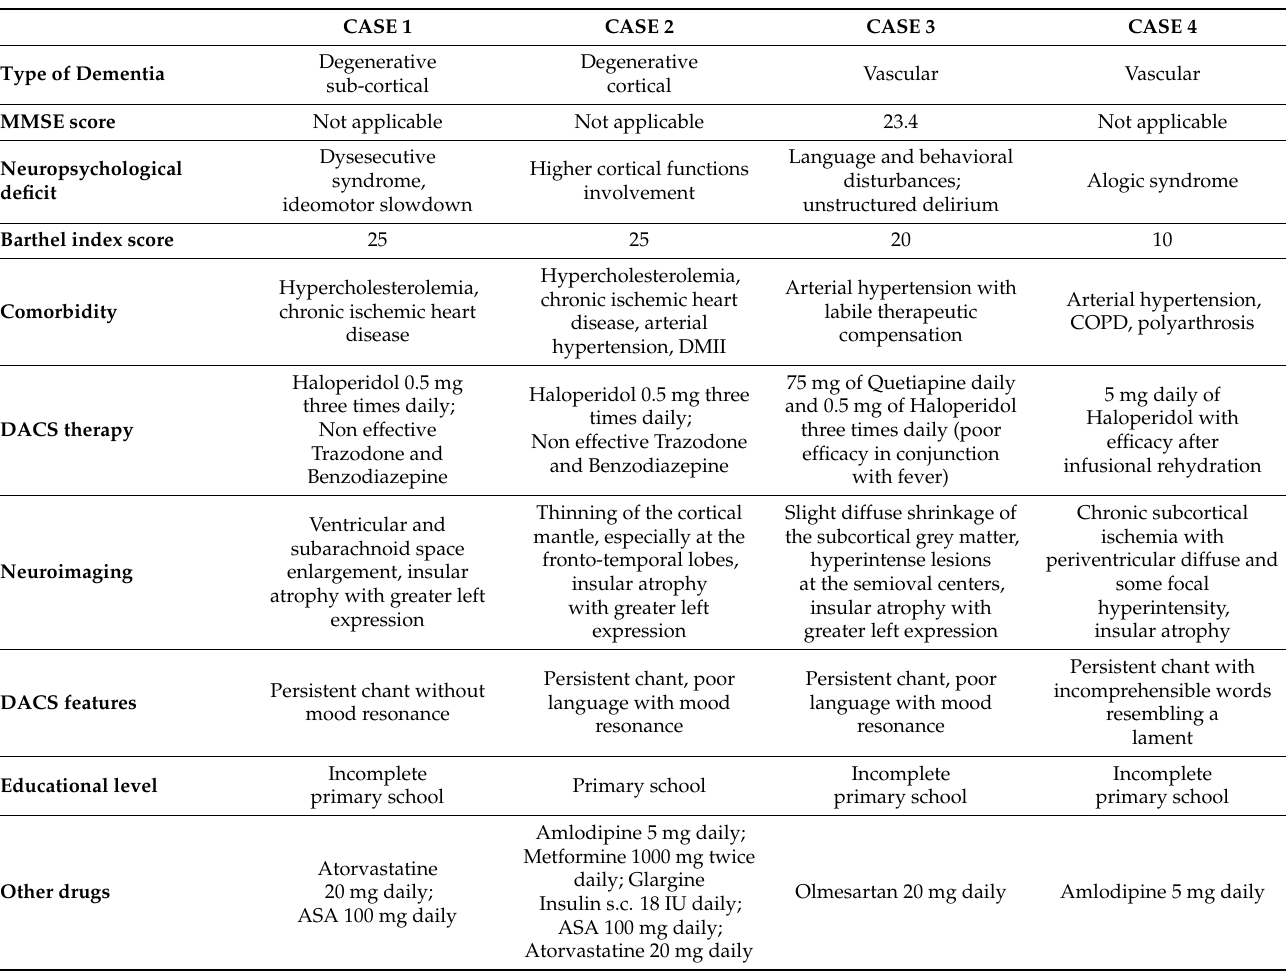
Table 1 resumes clinical remarks of the four patients and core features of DACS. Table 1. The clinical features of four unpublished cases affected by